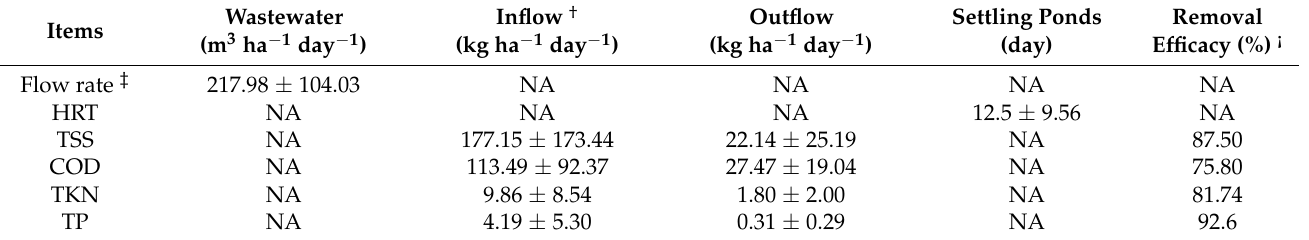
Table 2. Flow rates of wastewater, HRT and loading rate of TSS, COD, TKN, and TP, and removal efficacy of biological settling